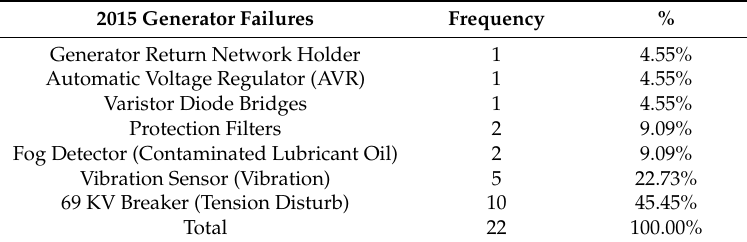
Table 3. Statistical analysis of failure time data, December 2015.